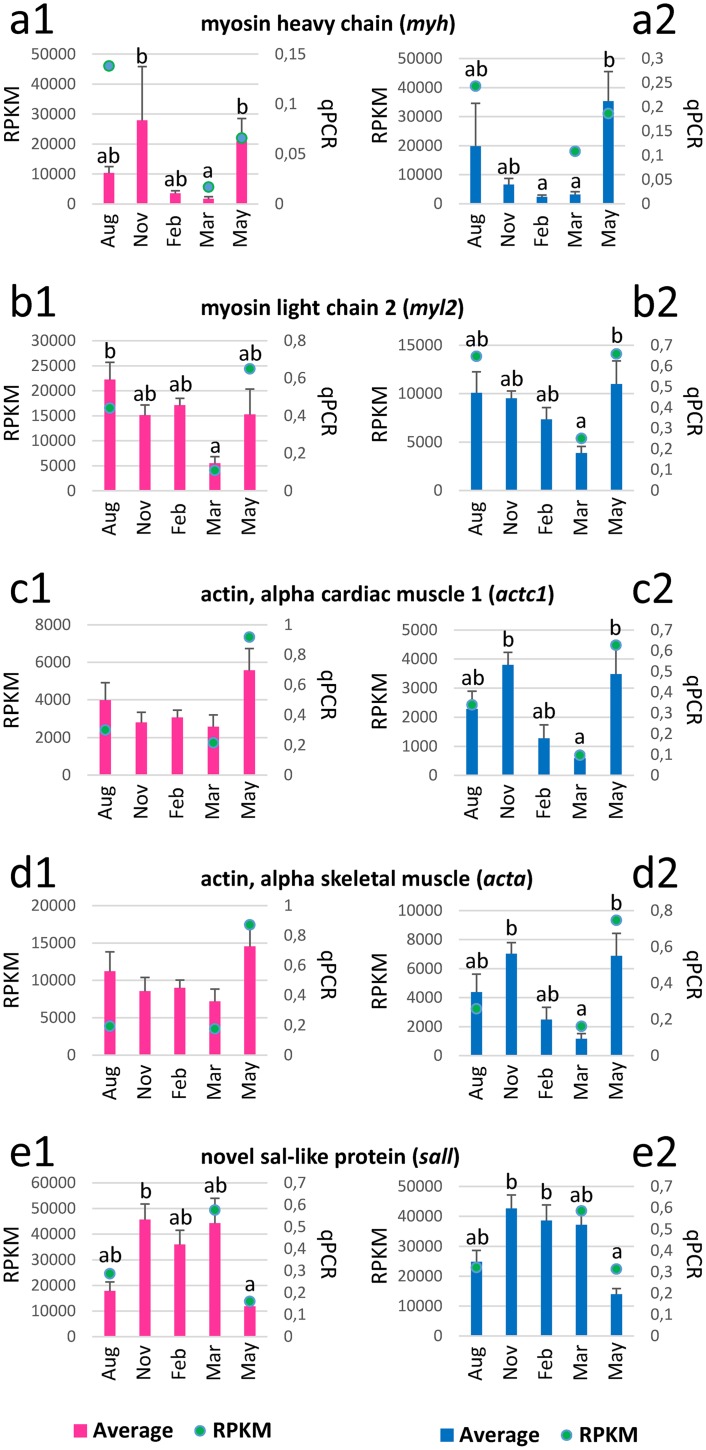
qPCR quantification of five DEGs in fast skeletal muscle throughout a reproductive cycle and comparison with RPKM values from RNA-Seq.Pink and blue bars show the relative mRNA expression in females and males, respectively. Green dots indicate RPKM values from the RNA-Seq. Error bars show S.E.M. at each point (n = 6 for each sex). Different superscript letters indicate significant differences within sex at p < 0.05.